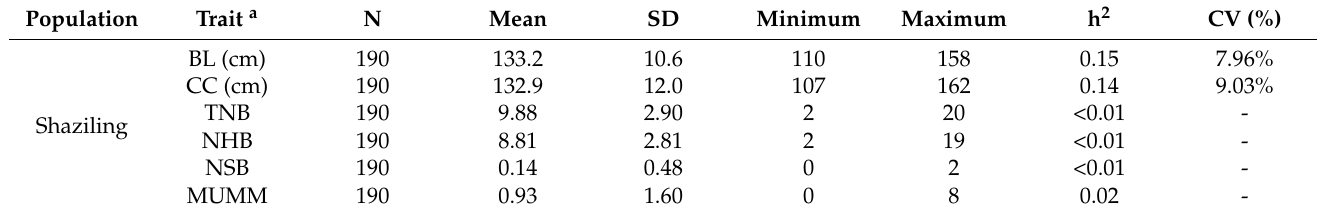
Figure 1. The normal distribution and correlation analysis between body size and reproduction traits. “ *** ” represents for p < 0.001. TNB: total number born. NHB: number of healthy births. CC: chest circumstance. BL: body length. Table 1. Summary statistics of body measurement and reproduction traits in the Shaziling population. Population Trait